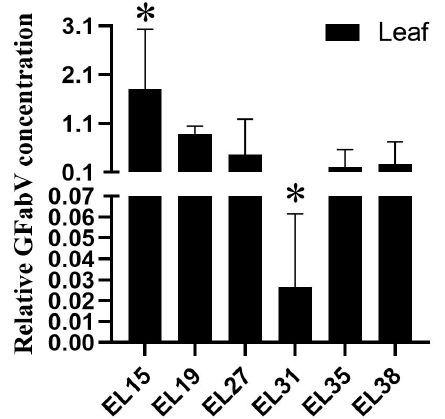
Figure 1. Quantification of grapevine fabavirus (GFabV) RNA in leaves of ‘Summer Black’ as determined by RT–qPCR. Samples were collected from six developmental stages in 2019 (EL15, 19, 27, 31, 35, and 38). Data are expressed as mean ± SE of biological and technical replicates. Bars represent the standard error of the mean. Asterisks indicate significant differences between GFabV-infected and GFabV-free leaves. ( p < 0.05)